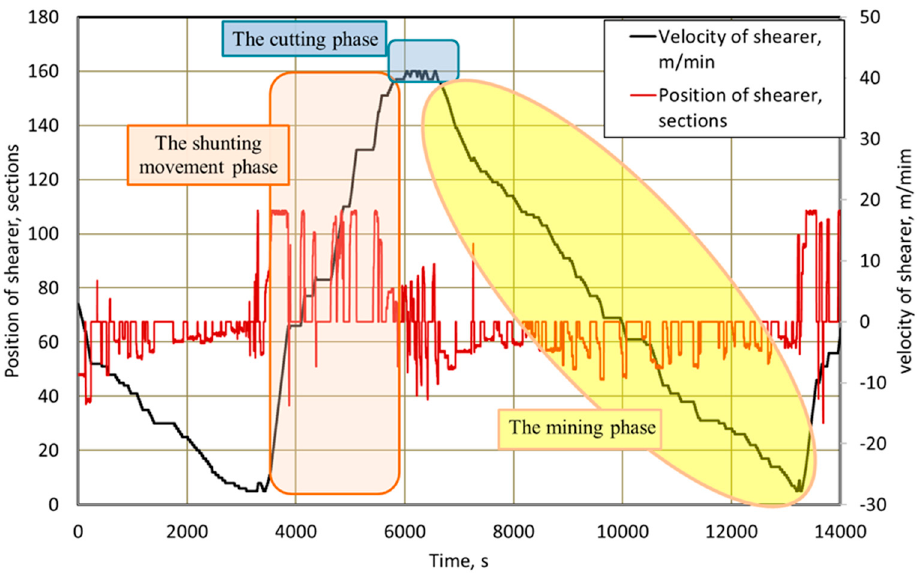
Figure 5. Time waveforms of changes in the position and speed of the shearer loader in the longwall face.